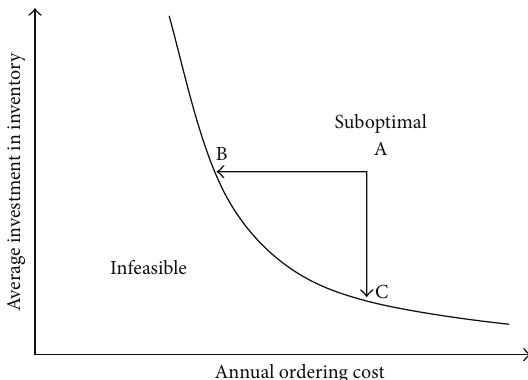
Figure 1: The exchange curve for deterministic inventory